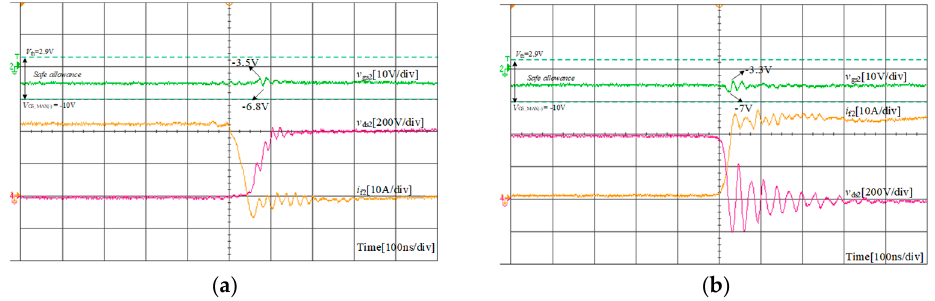
Figure 10. Experimental results with the proposed driver. ( a ) during Q 1 turn-ON transition, and ( b )